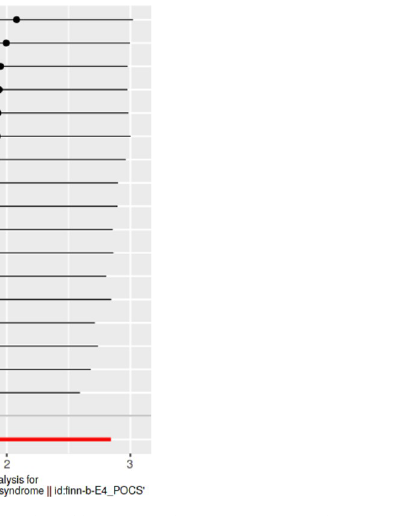
Fig 12. Leave-one-out sensitivity analysis plot of hip circumference, against polycystic ovarian syndrome as the outcome. A given dark point indicates the effect measure from inverse variance weighted Mendelian randomization analysis excluding that specific SNP. The red lines indicate pooled analyses encompassing all SNPs via IVW-MR method (drawn for comparison). https://doi.org/10.1371/journal.pone.0269191.g012 SNPs underlying their significant causal associations with PCOS. There were 11 SNPs underly- ing the significant causal association between weight and PCOS and 37 SNPs underlying the association between BMI and PCOS. Two common SNPs ( rs10938397 , rs543874 ) were observed across these four associations. The number of genes underlying the associations of weight, BMI, and WC/HC versus PCOS were 11, 40, and 21, respectively. Of these, 5 genes ( GNPDA2 , MC4R , SEC16B , TMEM18 , ZFP64 ) were shared across the four significant associa- tions. Of the 11 neighboring genes underlying the weight-PCOS association, only 4 ( H2BC7 , HMGA2 , MTIF3 , ZBTB38 ) were exclusive/non-shared. Of the 40 neighboring genes underly- ing the BMI-PCOS association, only 19 ( ADCY3 , AMPD2 , BEND5 , ETV5 , FOXG1 , FTO , GPRC5B , HNF4G , LMX1B , MTCH2 , NPC1 , PDK4 , PTBP2 , RASA2 , SKOR1 , STK33 , TLR4 ,